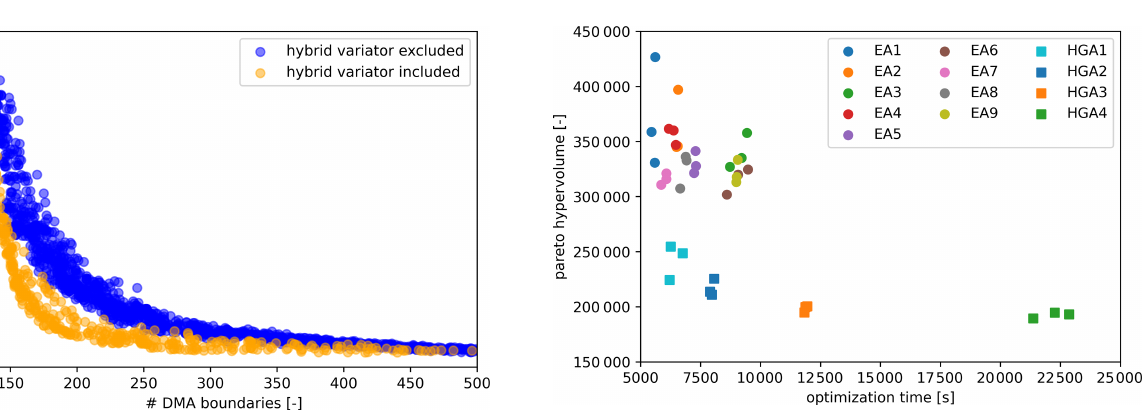
Figure 13. Solutions of the Pareto fronts that followed from the experiments summarized in Table 2. Blue corresponds to the results from EA1 to EA9; orange corresponds to the results from HGA1 to HGA4.